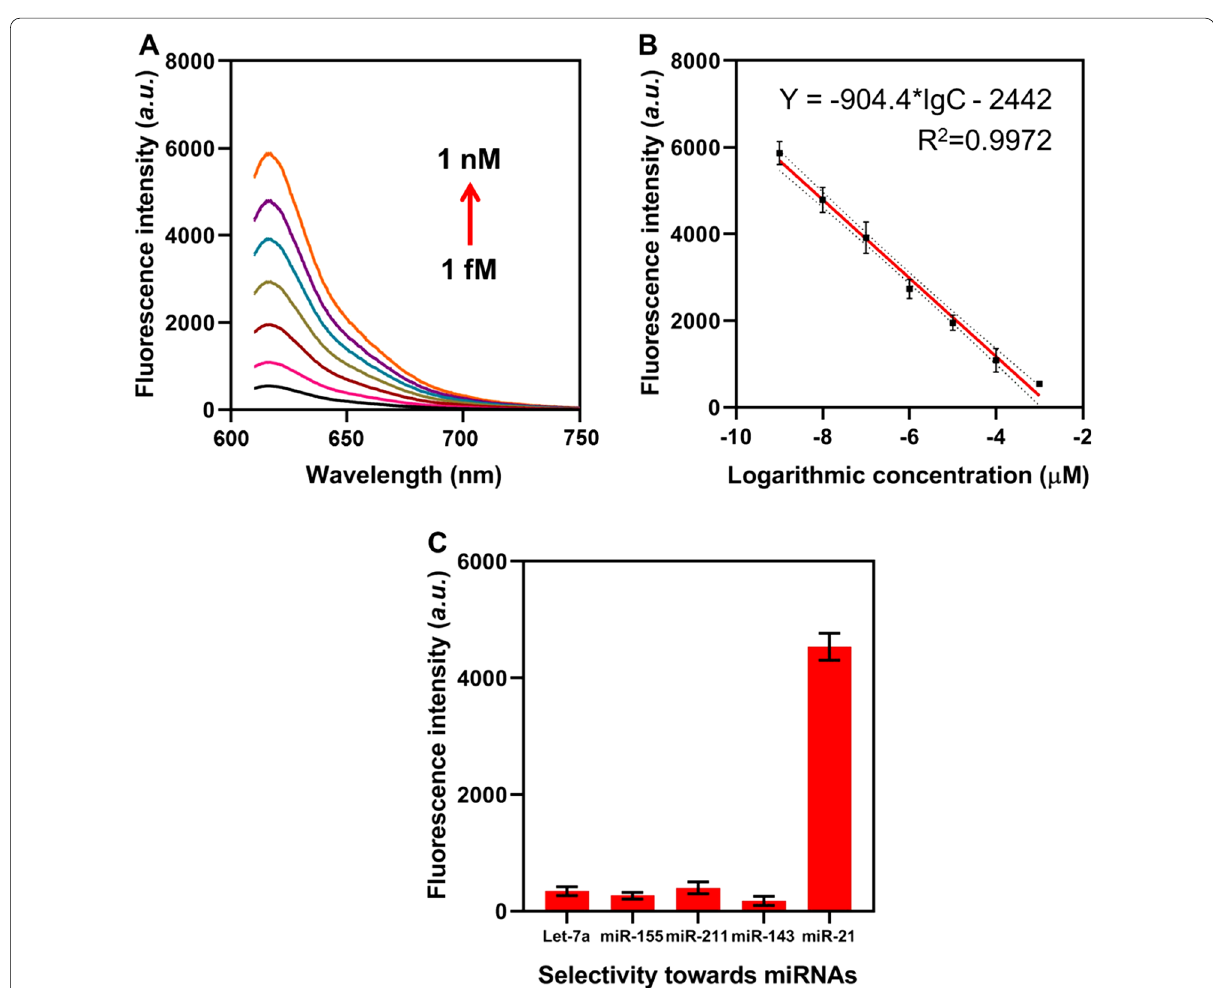
Fig. 5 Detection performance of the approach. A Fluorescence spectrum of the approach when detecting different concentrations of miRNA-21. B Correlation equation between the obtained fluorescence intensities and logarithmic concentrations of miRNA-21. C Fluorescence intensity of the approach when detecting different